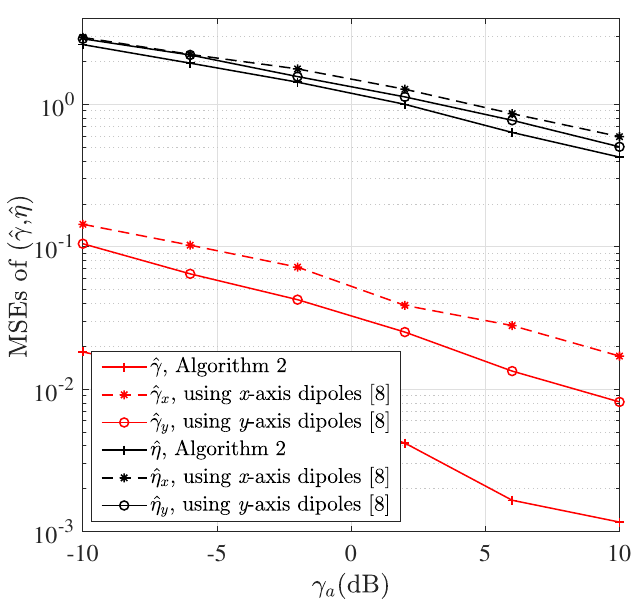
Figure 5. The MSEs of ( ˆ γ , ˆ η ) versus γ a